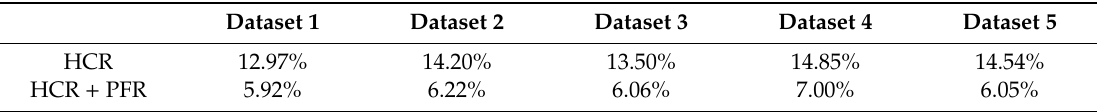
Table 5. Comparison of the prediction average relative deviations of boiling point for tail oil with the HCR model and HCR + PFR